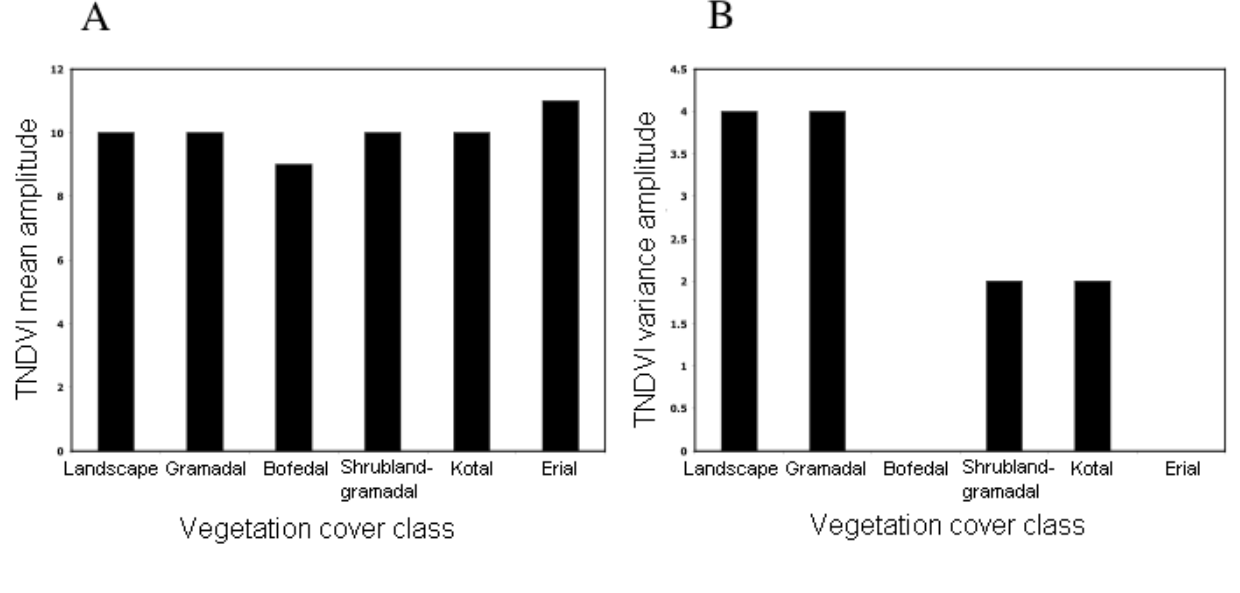
Fig. 6. Mean-variance portraits are quantified in terms of characteristics of ecological resilience, particularly by amplitude. Amplitude is the magnitude of the response of the landscape’s transformed normalized difference vegetation index (TNDVI) from reference conditions (in 1972) during or after a disturbance (in 1984). The amplitude for each statistic is calculated by subtracting (A) the mean TNDVIs for 1972 and 1984 and (B) the mean of the TNDVI variances for 1972 and